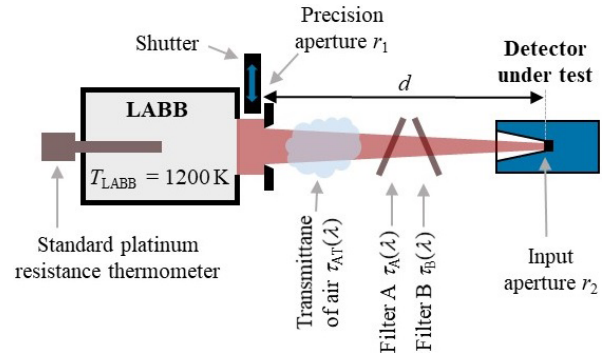
Figure 1. Measurement setup for the detector calibration regarding the spectral responsivity at the large-area blackbody (LABB) with a precision aperture and two transmission